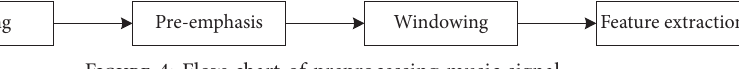
Figure 4: Flow chart of preprocessing music